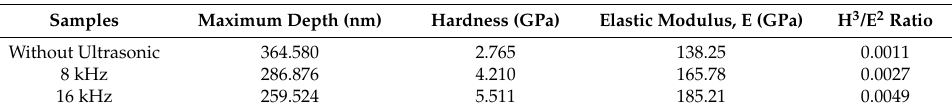
Table 1. Summary of output data from the nanoindentation test for ultrasonic treatment at 16 kHz for different holding times.